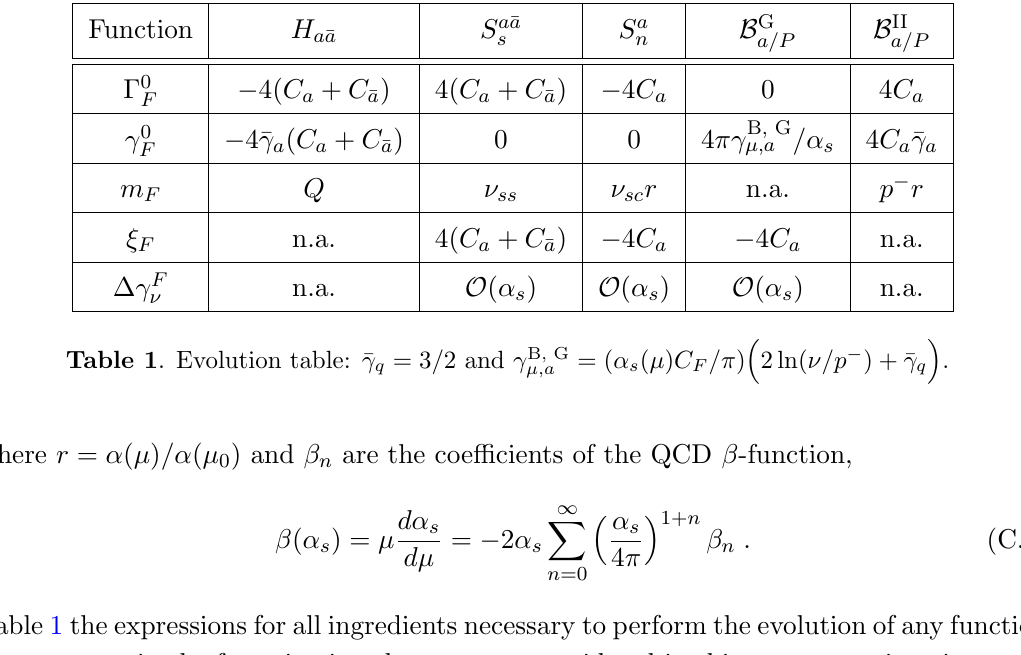
= 3 = 2 and (cid:13) B, G q